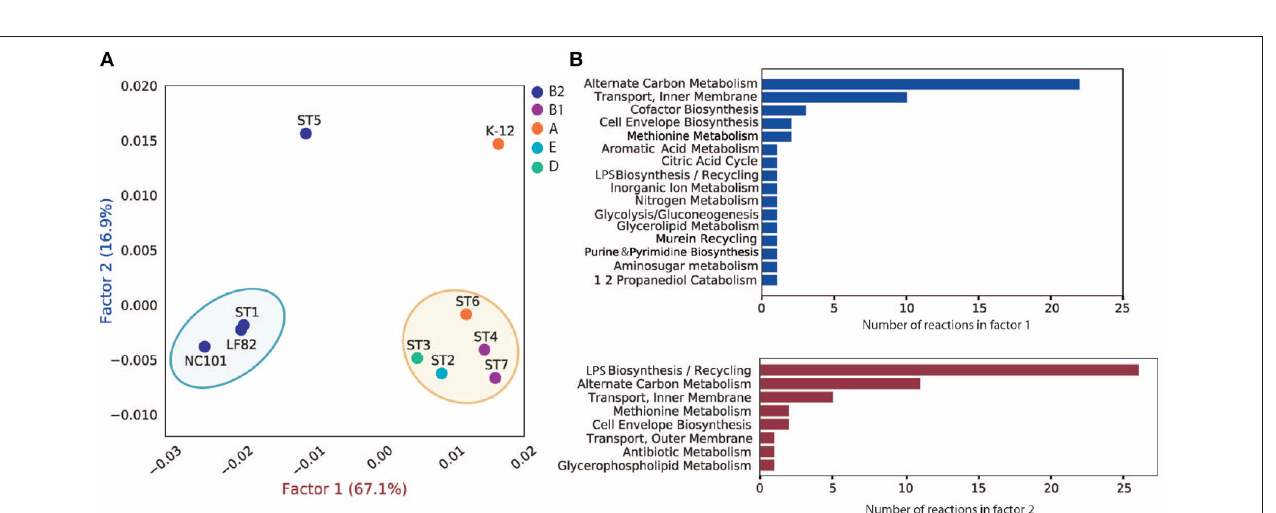
FIGURE 3 | Distribution of 57 genes that were implicated in AIEC pathogenesis in ten strains. Genes unique to ST1, NC101, and LF82 are involved in various functions including capsule synthesis ( kpsT , Martinez-Medina et al., 2009), mucins protease ( vat-AIEC , Gibold et al., 2016), CRISPR-associated genes ( cys3, cas6, cys2, and cas1 , Zhang et al., 2015), invasion ( ibeA and its variant, Cieza et al., 2015), phage encoded VFs ( gipA , Vazeille et al., 2016), and propanediol utilization ( pduC , Dogan et al., 2014).